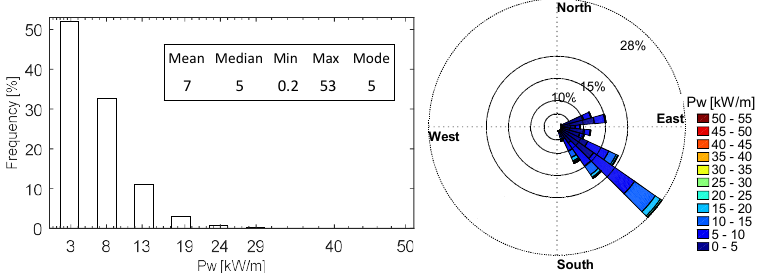
Figure 6. Total probability distribution of wave power P w versus mean wave direction MD ir . The frequencies of occurrence of sea states are given in percentage in Kilifi.